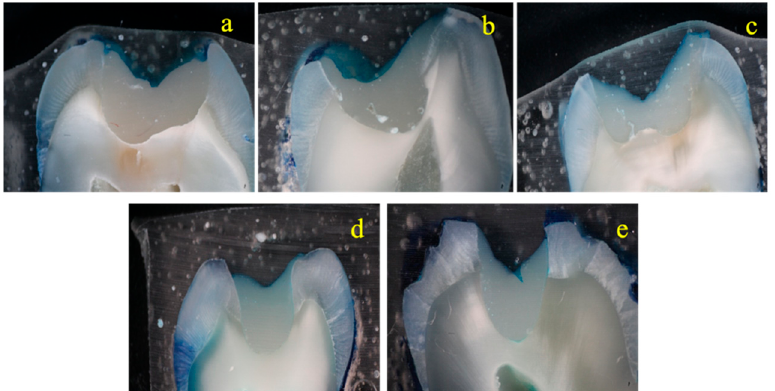
Figure 1. Microleakage scoring: ( a ) Score 0; ( b ) Score 1; ( c ) Score 2; ( d ) Score 3; ( e ) Score 4.